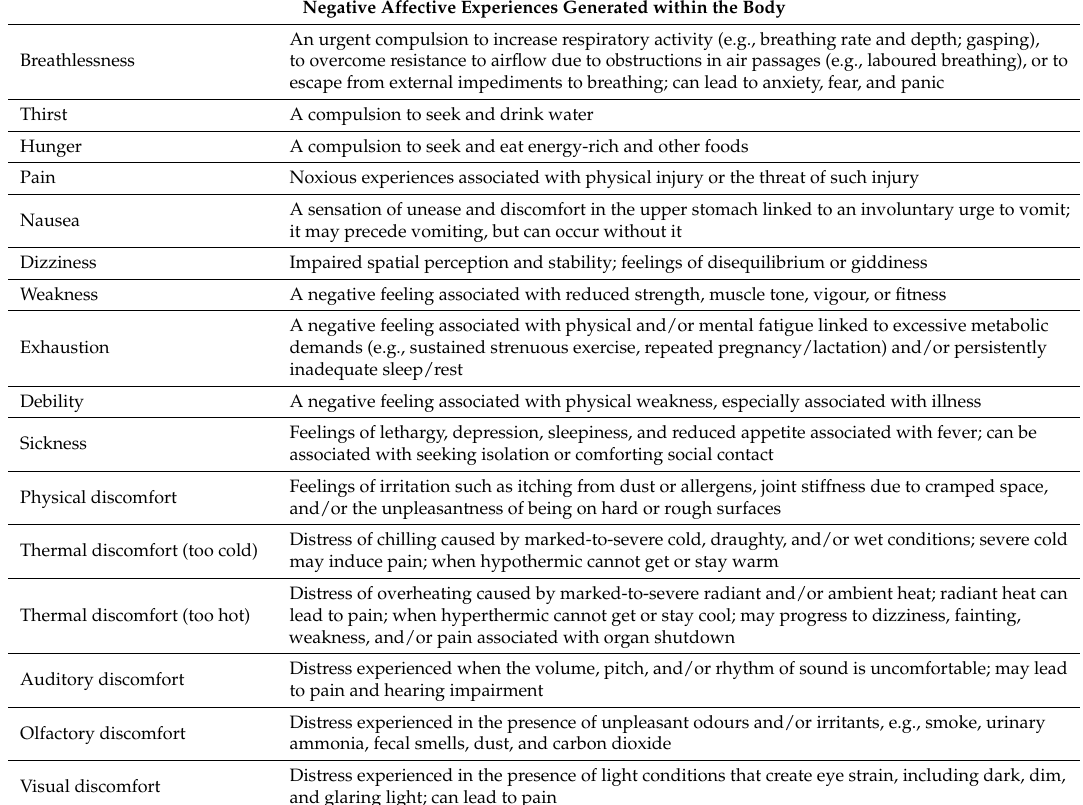
Table 1. Details of negative affective experiences generated within the body and others that reflect an animal’s perception of its external